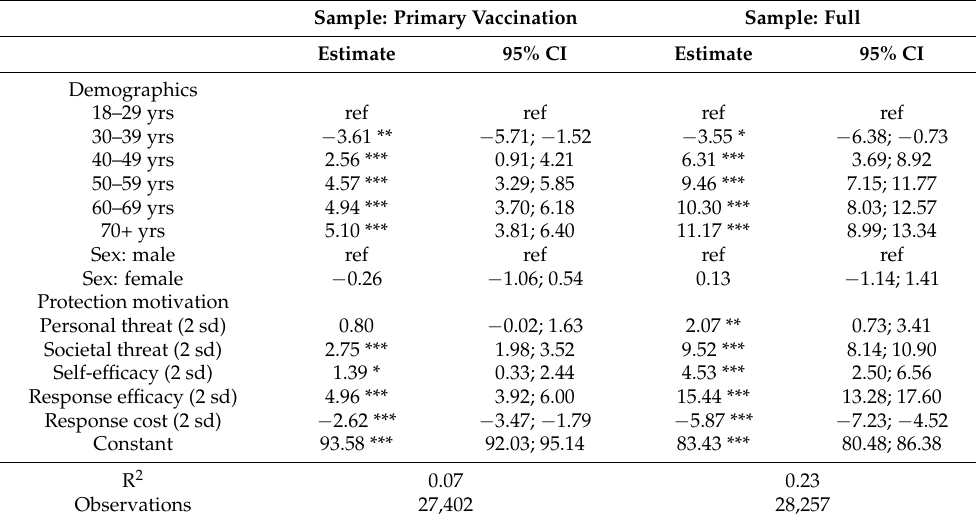
Table 3. Booster vaccine willingness, regression results.